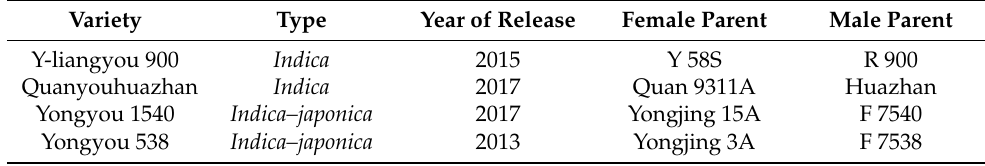
Table 1. Pedigrees and year of release of genotypes used in these experiments. Variety Type Year of Release Female Parent Male Parent Y-liangyou 900 Indica